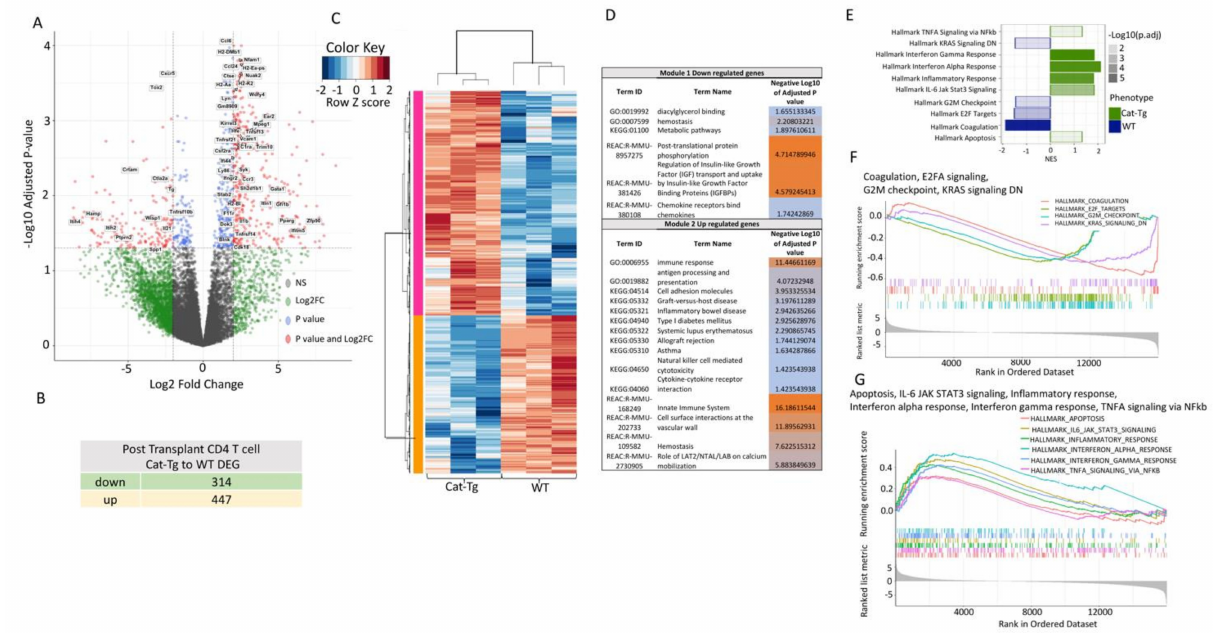
Figure 7. β -catenin overexpression differentially regulates gene expression in post-transplanted donor CD4 + T cells. ( A ) Volcano plot displaying 761 differentially expressed genes (FDR 0.05, logFC 2) between Cat-Tg and WT post-tx ≤ ≥ CD4 + T cell samples. Positive log fold change corresponds to increased expression in Cat-Tg samples. ( B ) Table showing the number of up- or downregulated DEGs between groups. ( C ) Hierarchical clustering and heat map illustrating expression of genes compared between different groups selected by strain and timepoint. All replicates are shown ( n = 3) for each group. ( D ) Table showing GO enrichment analysis of 761 DEG of post-tx CD4 + T cells. Using the online tool gProfiler and the ordered g:GOSt query, we assessed which biological processes (BP) were linked to the genes in the different modules from post-tx CD4 + T cells. On the table, adjusted p -values were color-coded as light blue for insignificant findings to orange with highest significance. ( n = 3 mice per group). ( E ) A bar plot showing up- or downregulated pathways based on enrichment scores in GSEA in post-tx WT or Cat-Tg CD4 + T cell samples. Negative Normalized Enrichment Score (NES) is indicator of downregulation and positive NES is indicator of upregulation of the genes in the corresponding pathway. Color specifies the group ( WT or Cat-Tg) in which expression is altered (phenotype), color transparency indicates the negative Log10 of adjusted p value. ( F ) GSEA enrichment plots of gene clusters that are enriched in WT, including Hallmark of Coagulation, Hallmark of E2FA signaling, Hallmark of G2M checkpoint, Hallmark of KRAS signaling DN. ( G ) GSEA enrichment plots of gene clusters that are enriched in Cat-Tg, including Hallmark of Apoptosis, Hallmark of IL-6 JAK STAT3 signaling, Hallmark of Inflammatory response, Hallmark of Interferon-alpha response, Hallmark of Interferon-gamma response, and Hallmark of TNFA signaling via NF κ